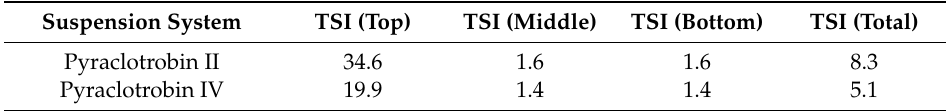
Table 1. TSI of two pyraclostrobin suspension systems.